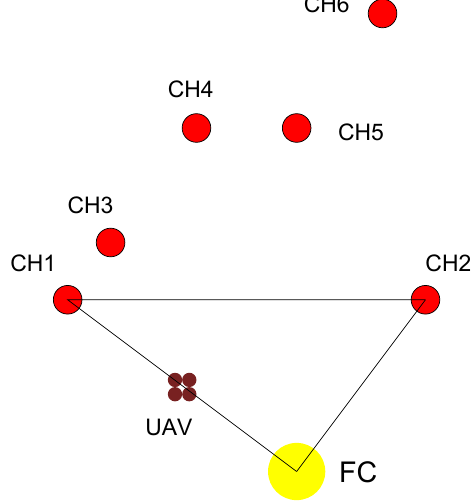
Figure 2. The whole multi-robot system consists of a fusion center (FC) where the UAV starts its route and six clusters of robots around FC. The red circles show the locations of the six cluster head (CH) robots in their robot cluster. The UAV uses the strategy π 0 for the data collection . With respect to this initial position of the UAV at ξ 0 = ( 0,0 ) , the positions of the CH robots are ( ξ 1 , ξ 2 , ξ 3 , ξ 4 , ξ 5 , ξ 6 ) = (( − 16,12 ) , ( 9,16 ) , ( − 13,16 ) , ( − 7,24 ) , ( 0,24 ) , ( 6,32 ))